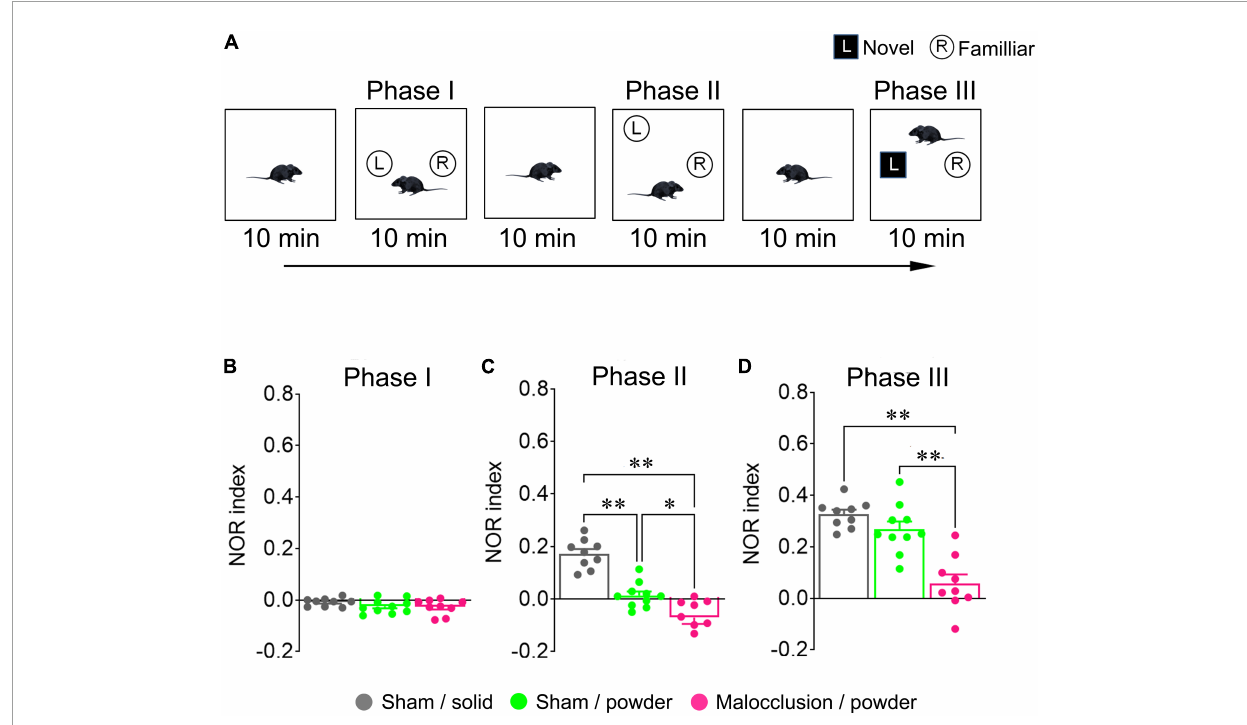
FIGURE2 Schematic illustration of novel object recognition (NOR) test and NOR indices. All mice in Sham/solid ( n = 9), Sham/powder ( n = 10), and Malocclusion/powder group ( n = 9) were subjected to NOR test on Day 28 (A) . NOR indices in Phases I (B) , II (C) , and III (D) were calculated. Data are represented as means ± SEM. Differences were considered significant at * p < 0.05 and ** p <